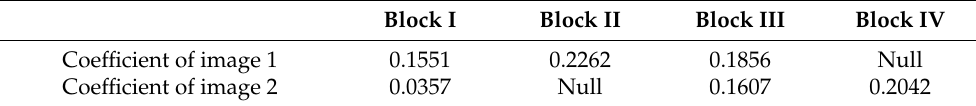
Figure 13 . Selecting the blocks of images. ( a ) Original image. ( b ) Selected blocks. Figure 13. Selecting the blocks of images. ( a ) Original image. ( b ) Selected blocks. Table 2. The coefficients of variation of each block.